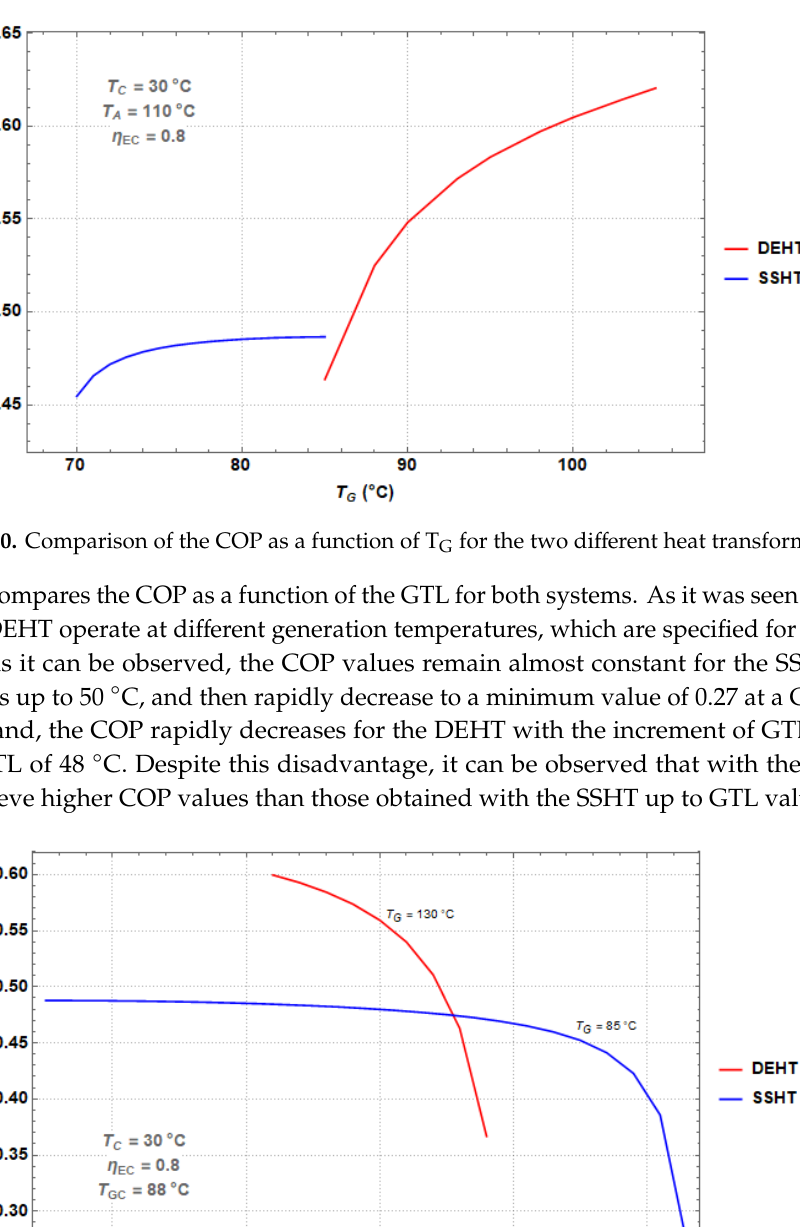
Figure 11. Comparison of the COP as a function of the GTL for the two different heat transformers.